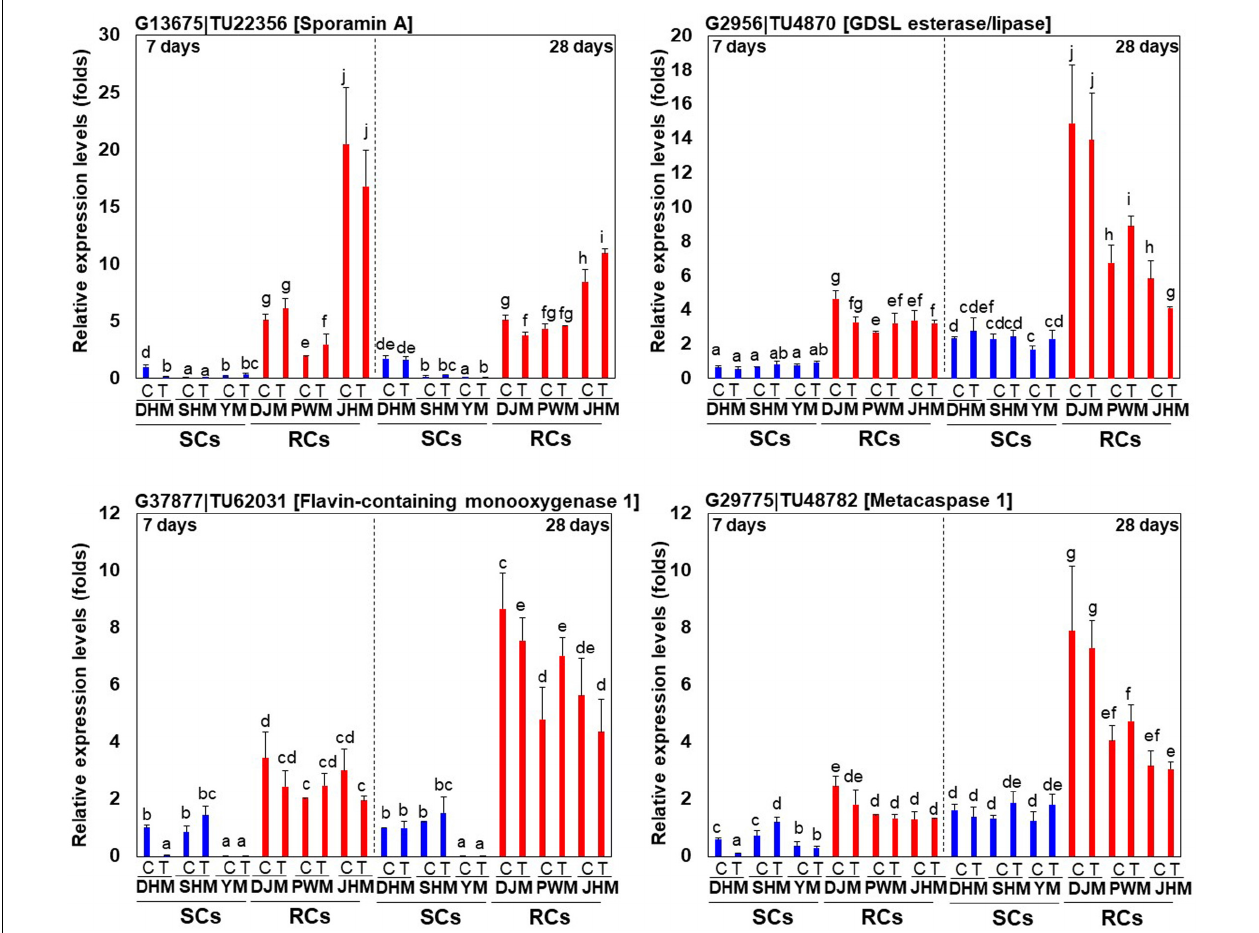
FIGURE 9 | Expression profiling of RC-specific RKN resistance marker genes. Relative transcript levels of DEGs encoding protease inhibitor sporamin A (G13675| TU22356), lipid-related GDSL lipase (G2956| TU4870), secondary metabolism-related flavin-containing monooxygenase G37877| TU62031) and protease metacaspase (G29775| TU48782) in RKN-infected sweetpotato cultivars are shown. DHM, Dahomi; DJM, Danjami; PWM, Pungwonmi; SHM, Shinhwangmi; JHM, Juhwangmi; YM, Yulmi; RCs, resistant cultivars; SCs, sensitive cultivars; C, control; T, treatment. Bars denoted with the same letter are not significantly different ( P = 0.05) according to Dunnett’s